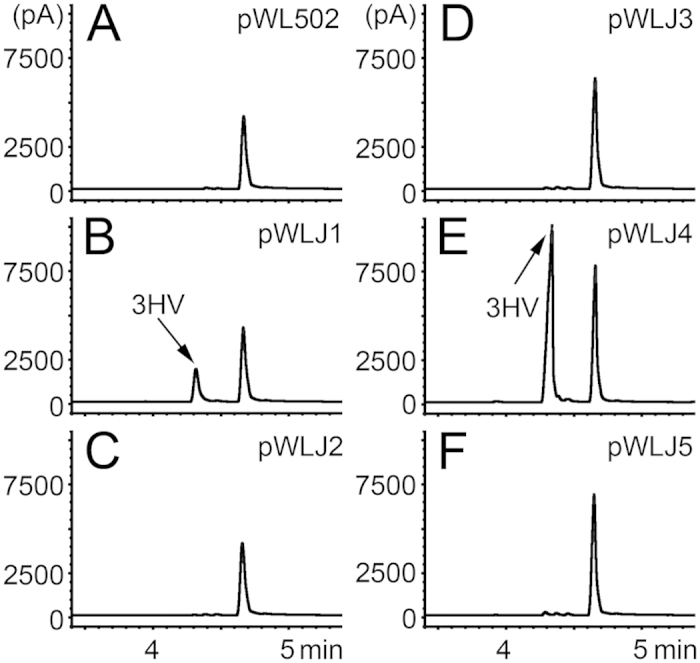
Effect of phaJs complementation on PHV accumulation in the mutant H. mediterranei EPSΔ5J2B.The mutant strain harboring plasmid pWL502 (empty plasmid, (A)), pWLJ1 (B), pWLJ2 (C), pWLJ3 (D), pWLJ4 (E), and pWLJ5 (F), individually, were grown in PAC medium with valeric acid added. The monomer (3-hydroxyvalerate, 3HV) is shown with an arrow. The peak at 4.7 min represents methyl benzoate, which is used as an internal standard for quantitative calculation. pA indicates picoampere.